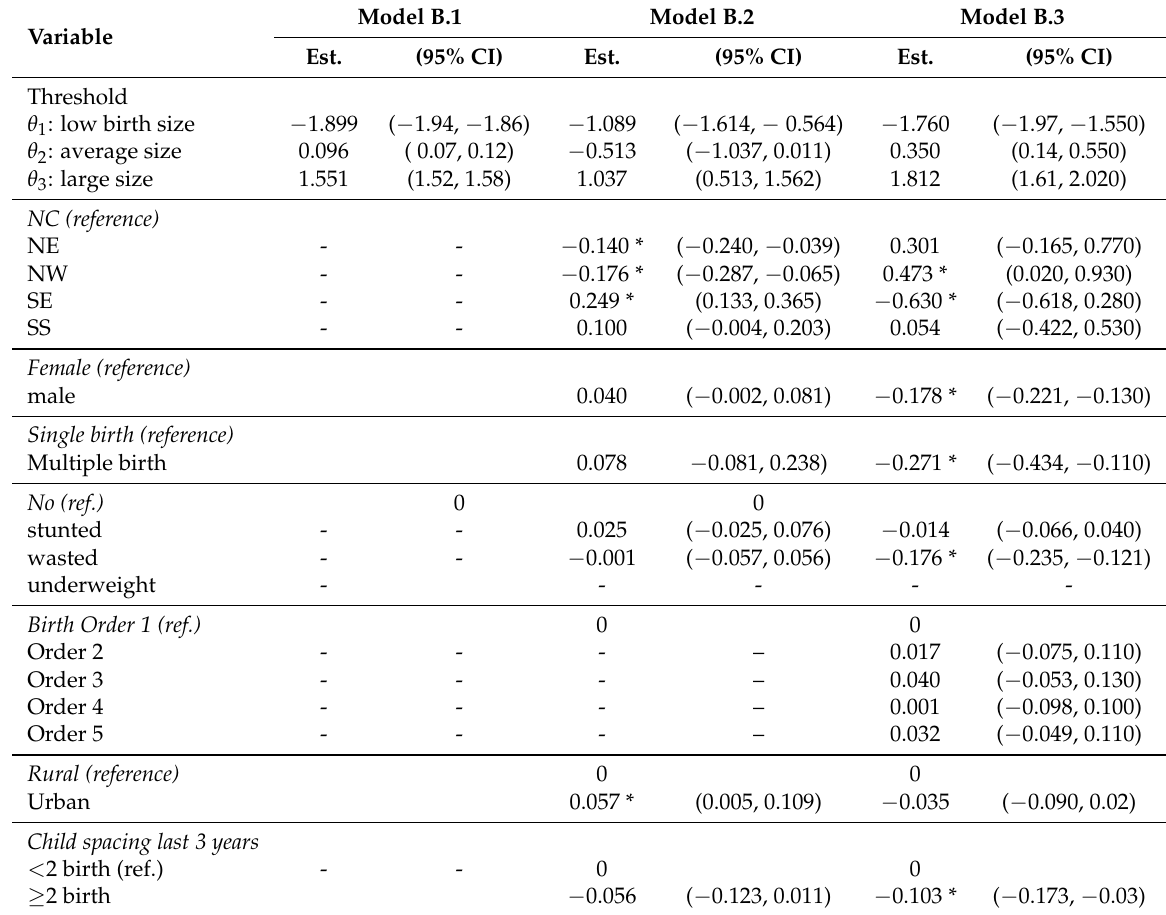
Table 7. Summary of of three Multinomial logit